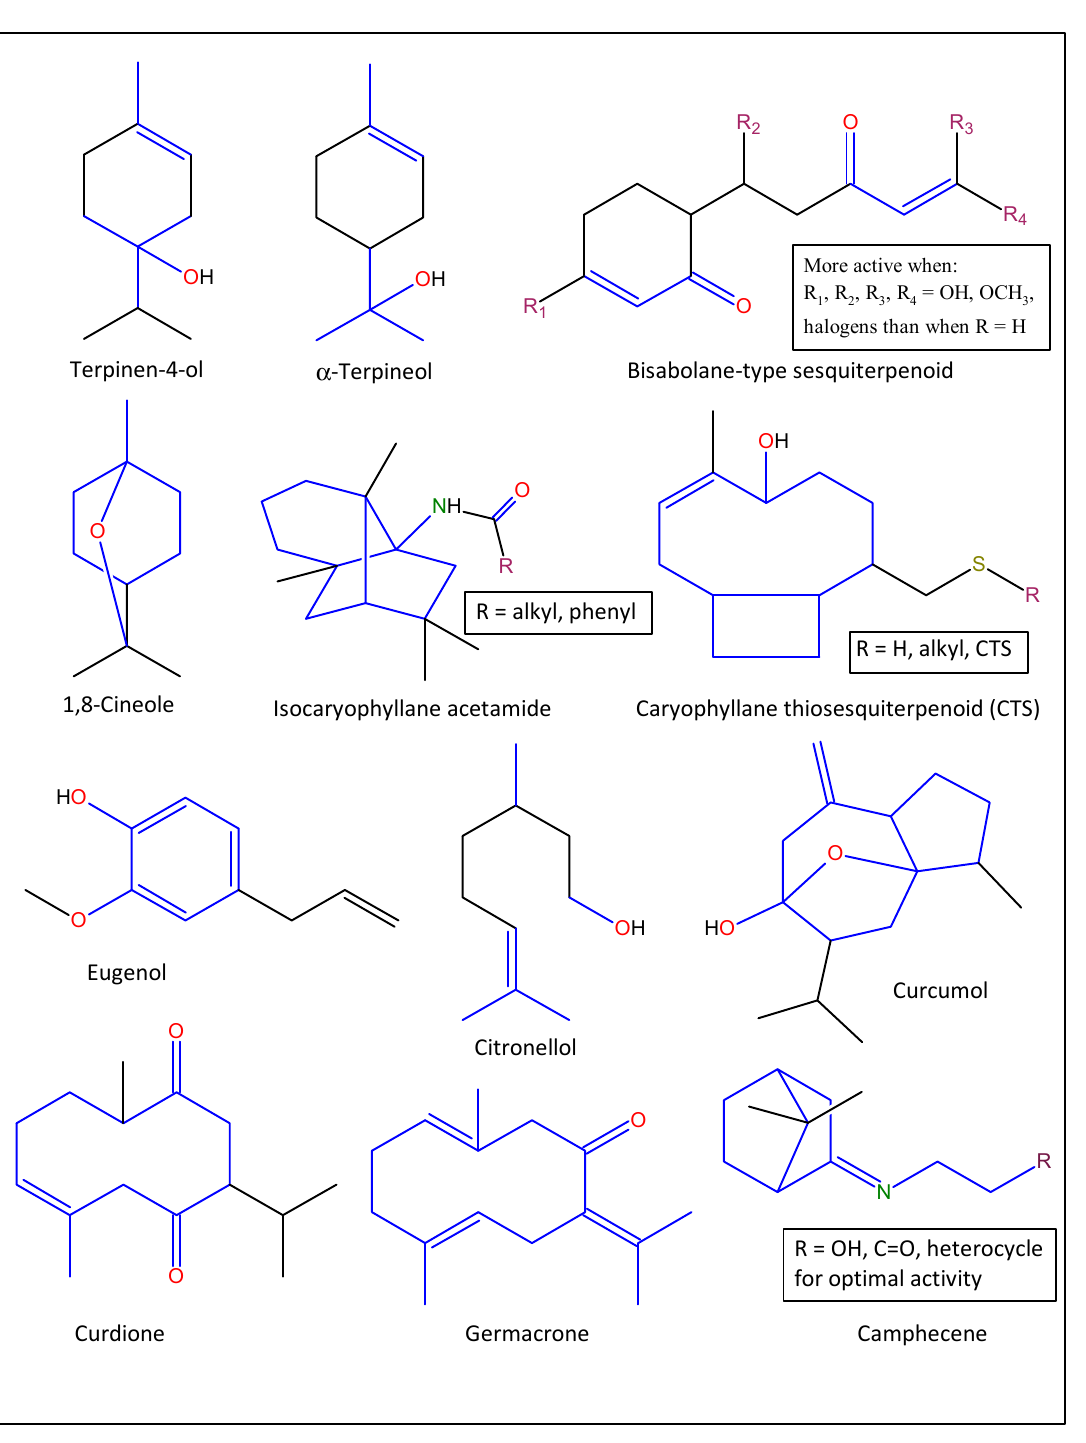
Figure 6. Structures of some lead anti-influenza essential oil compounds showing their active moieties (colored).